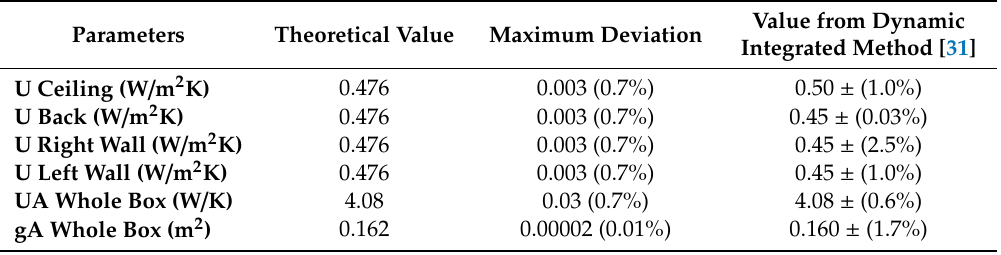
Table 1. Theoretical values of the characteristic parameters and estimated ranges of deviations from their constant values, and values obtained applying other analysis method